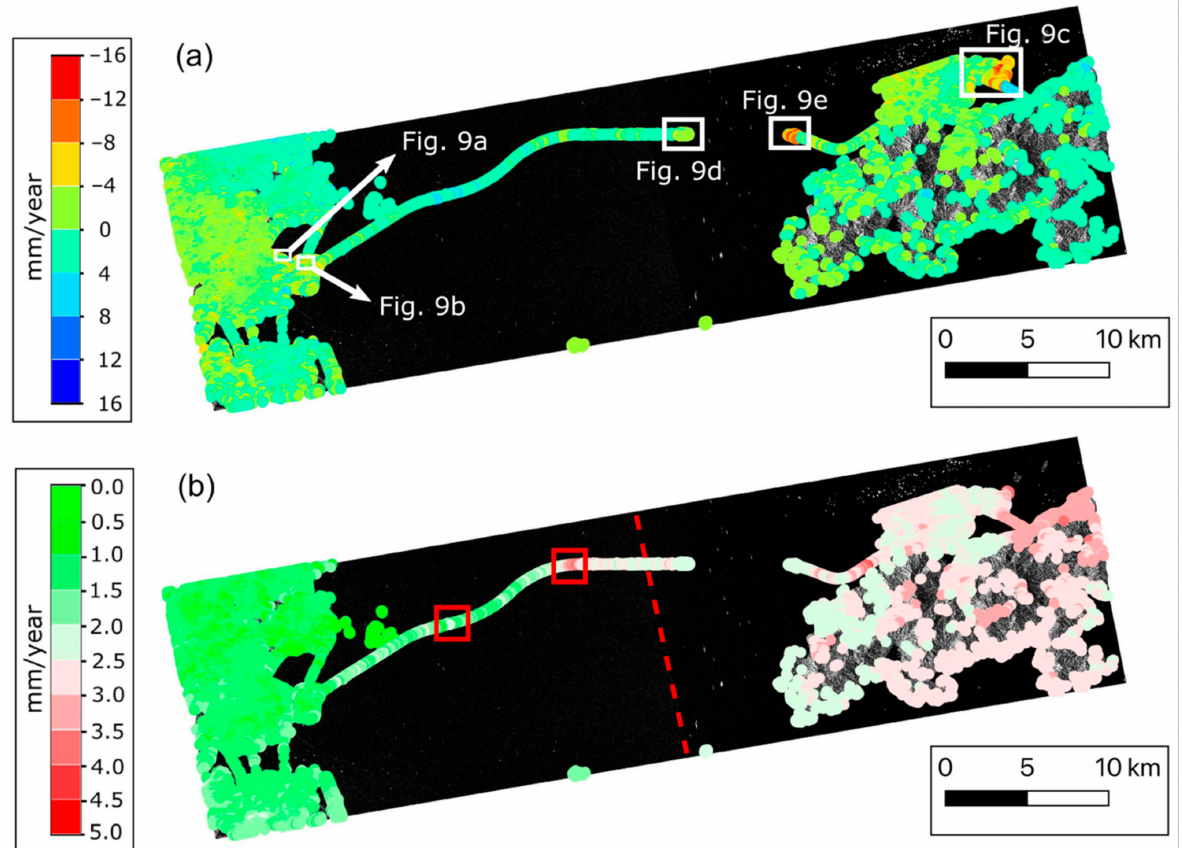
Figure 7. PS-InSAR results of the HZMB bridge: ( a ) the displacement velocity, regions in the white boxes are enlarged in Figure 9a–e; ( b ) the standard deviation map of regression. The red boxes indicate the abnormal changes, and the red dashed line is the boundary between swath 2 and swath 3.